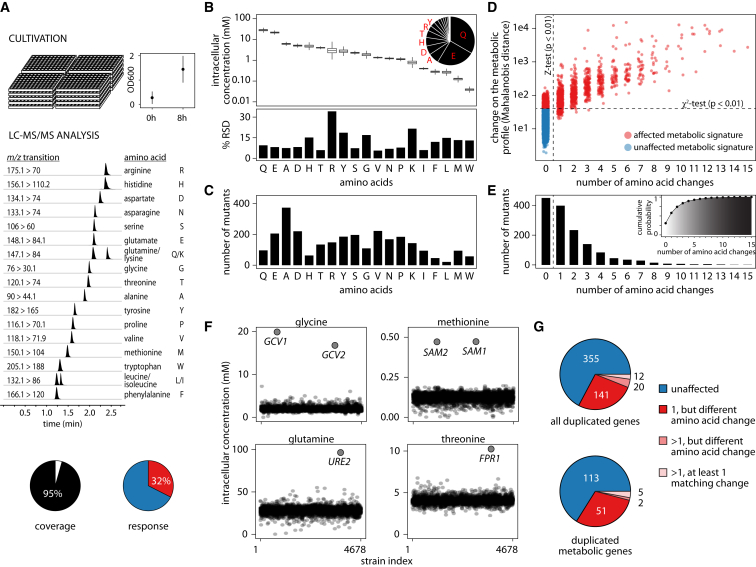
Genome-Metabolome Interactions that Affect Amino Acid Biosynthetic Metabolism(A) Amino acid quantification in a genome-scale collection of Saccharomyces gene deletion strains, grown in minimal synthetic medium, harvested in exponential phase (mean ± SD, nt0 = 92, nt8 = 83), and processed by hydrophilic interaction liquid chromatography (LC) selective reaction monitoring (SRM) for the precise quantification of amino acids. Middle: representative SRM chromatogram (scaled). Bottom: 95% of viable deletion strains (99% of strains growing in minimal medium) were successfully analyzed; 32% possess a significantly changed metabolome.(B) Amino acid concentrations span over three orders of magnitude and are affected by gene deletions between 6% and 36%.(C) Amino acid concentrations are sensitive for up to 373 gene deletions per metabolite.(D) 1,519 gene deletions significantly affect the amino acid profile as identified by multivariate statistics (χ2-test, adjusted p value < 0.01, 1,459 deletion strains) and univariate statistics (Z-test, adjusted p value < 0.01, 1,069 deletion strains).(E) Amino acid signatures are predominantly specific, expressed as simultaneously changing amino acid concentrations (bar chart) and as cumulative percentage (insert). 75% of metabolic profiles are characterized by two or fewer concomitant changes.(F) Examples of quantitatively high and uniquely specific gene-metabolite interactions.(G) Duplicated genes specialize in metabolic function. 161 out of 173 genes in homology clusters (53 out of 58 metabolic genes) trigger qualitatively different metabolic signatures.